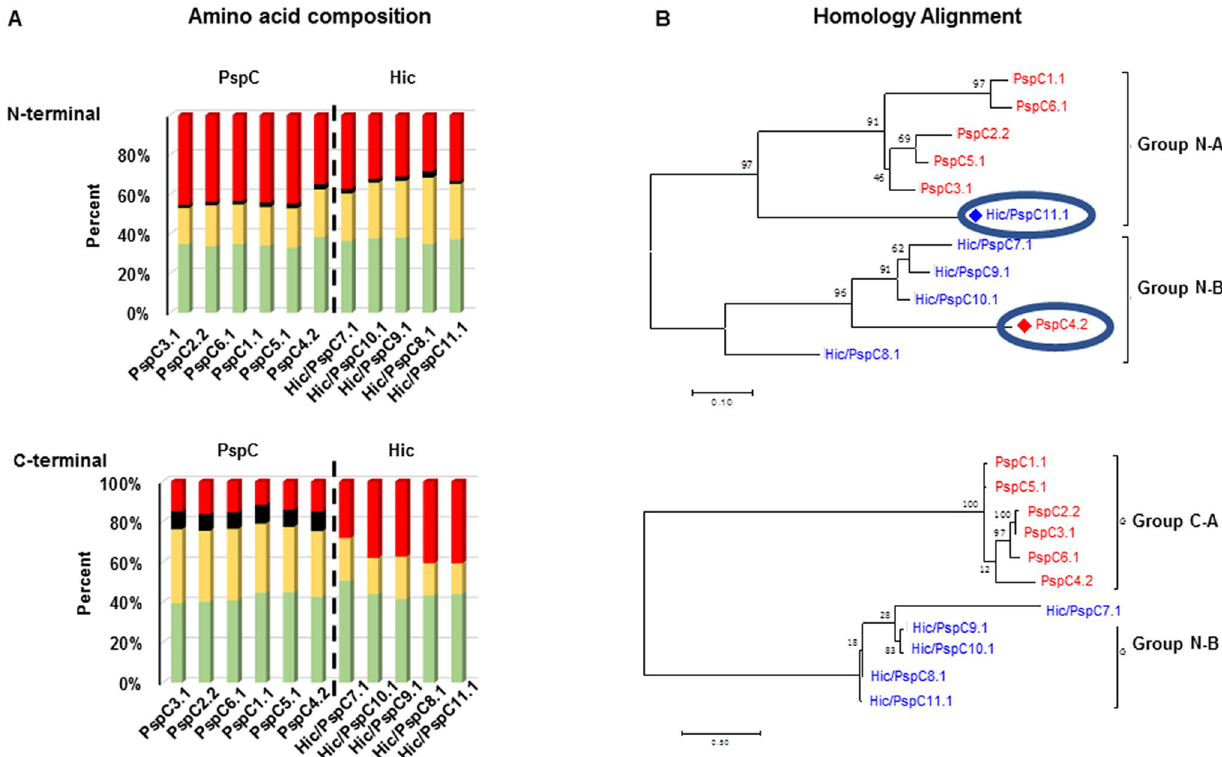
Figure 3. Differences in the N and C-terminal regions of the PspC and Hic variants. ( A ) The N and C-terminal regions of PspC and Hic type proteins differ in amino acid composition. The amino acid composition of the N and C-terminal regions was evaluated for each selected variant. The N-terminal regions of the six PspC and the five Hic variants are rich in charged residues (35–45%) and have a low number of both polar and amphipathic, and Tyr residues. The PspC variants had also a high proportion of charged residues (28–42%) (upper panel). The C-terminal regions of the PspC variants had a lower percentage of charged residues (16% or less) and more polar and hydrophilic (32–36%) and Tyr residues (8.3–9.1%). The composition of the C-terminal region of Hic variants differed from that of PspC variants. The C-terminal regions of Hic variants contained more charged residues, lower levels of Tyr and polar and amphipathic residues (lower panel). ( B ) Phylogenetic trees of the N and C-terminal regions of PspC and Hic type proteins. The homology alignment of the N and C-terminal regions identifies two groups. For the N-terminal regions group A is dominated by PspC type proteins, but also includes Hic/PspC11.1. Group B is dominated by Hic type proteins, but also includes the PspC4.2 variant. The C-terminal regions show a clear separation between the PspC and Hic